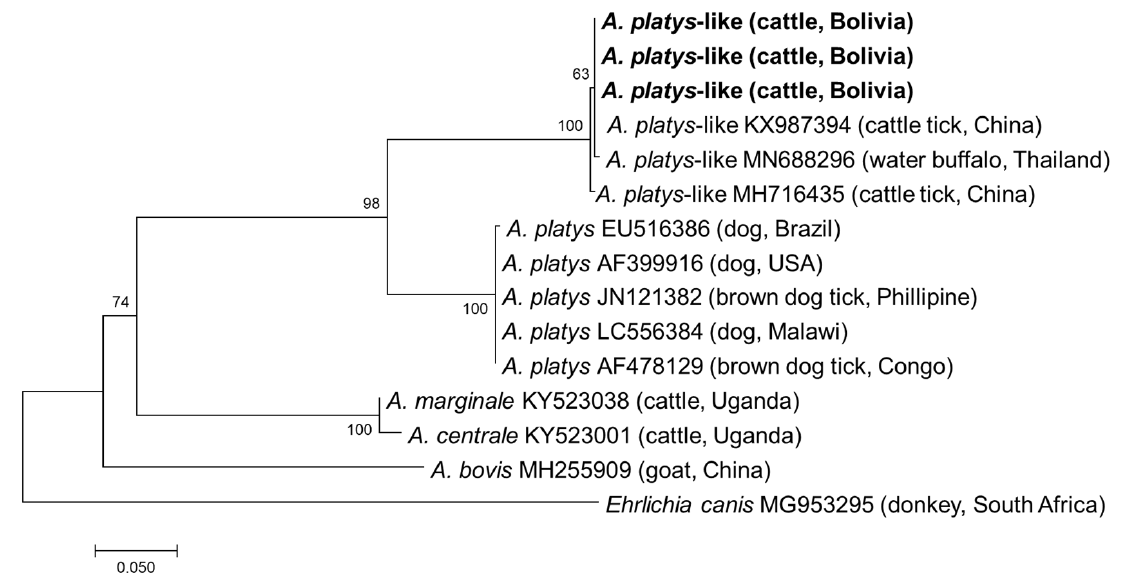
Figure 4. Phylogenetic tree based on the groEL sequences of Anaplasma species. The phylogenetic tree was constructed using MEGA7 based on the maximum likelihood method, using the Tamura 3-parameter model. Only bootstrap values greater than 60% are indicated. The sequences obtained in this study are shown in bold. The geographic origin (country) of each sequence/strain is provided in parentheses.